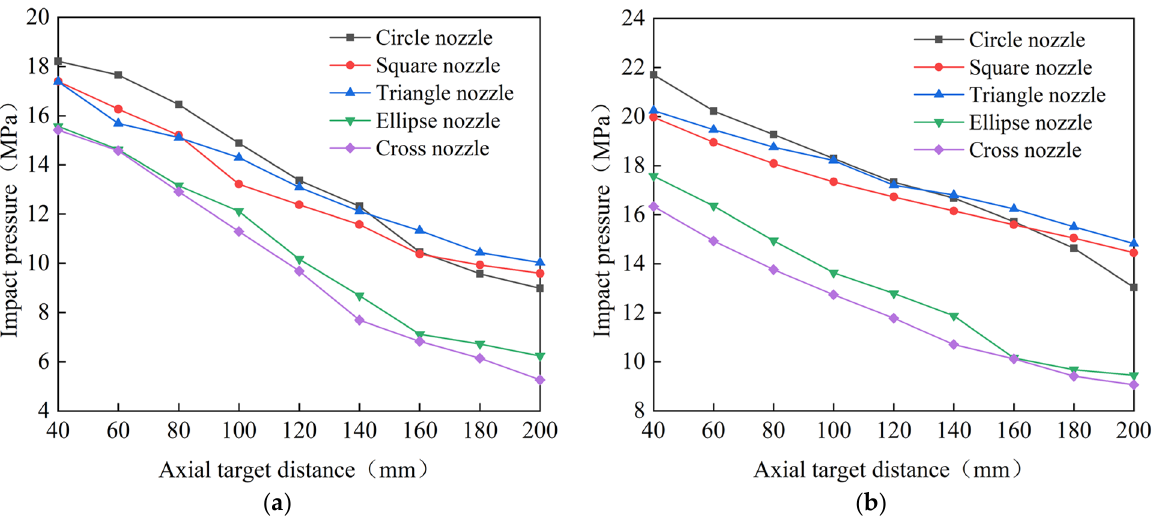
Figure 6. Axial distribution characteristics of water jet impact force under different nozzle shapes: ( a ) P = 20 MPa; ( b ) P = 25